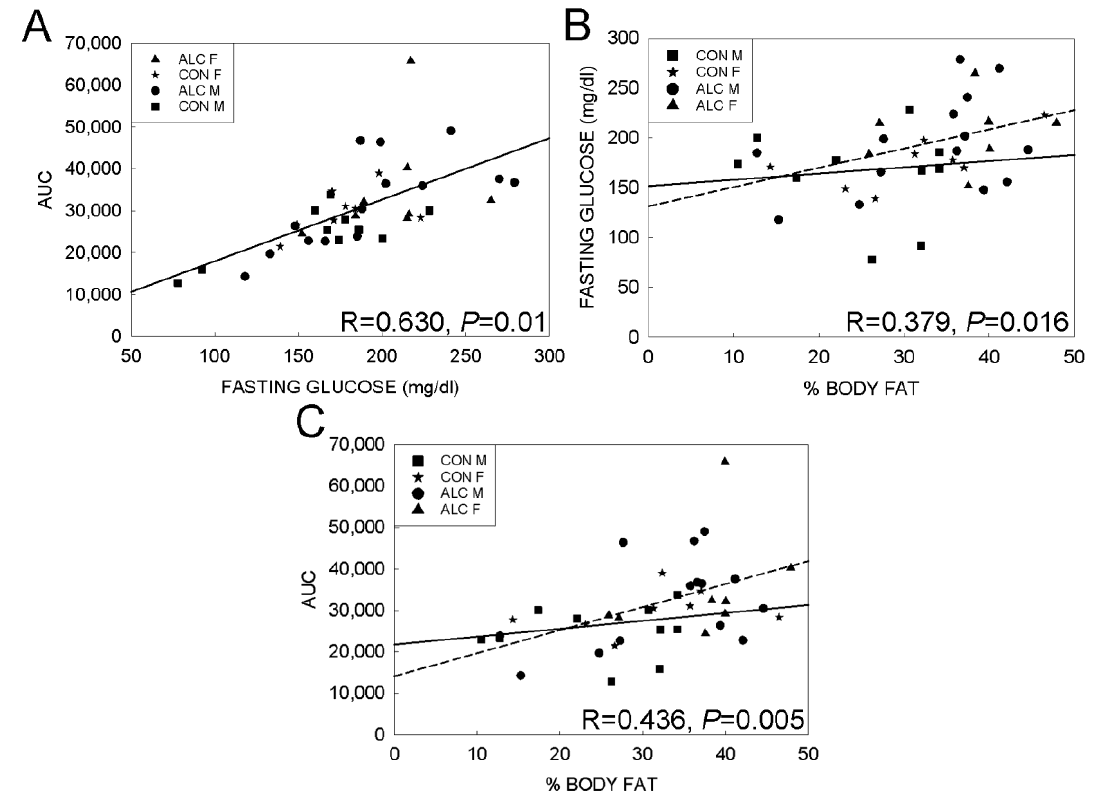
Figure 6. Association analysis between % body fat, fasting glucose, and glucose tolerance in 18-mo ALC and CON mice. ( A ) Linear regression shows a positive correlation between fasting glucose and AUC in all mice. ( B ) The correlation between % body fat and fasting glucose is positive for ALC mice but is not significant for CON mice. ( C ) The correlation between % body fat and AUC is positive for ALC mice but not for CON mice. For ( B , C ), lines represent the correlations for CON (solid) and ALC (dashed) mice; R values are for ALC mice only, as CON R values were not significant (see text for details). Symbols represent individual animals.